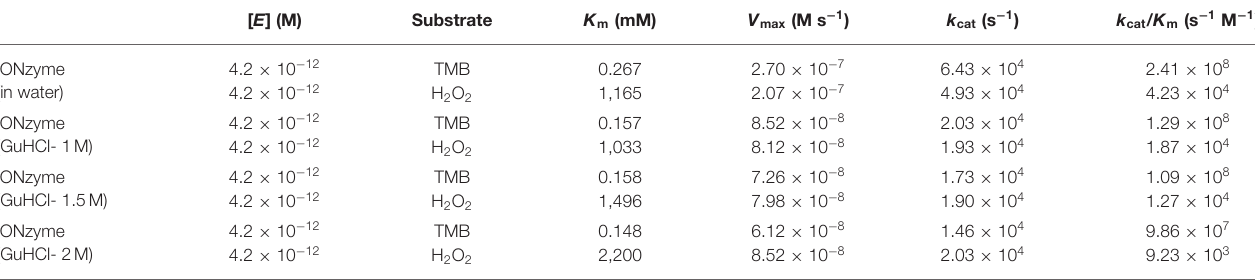
TABLE 1 | Comparison of the kinetic parameters of Fe 3 O 4 IONzymes in H 2 O or